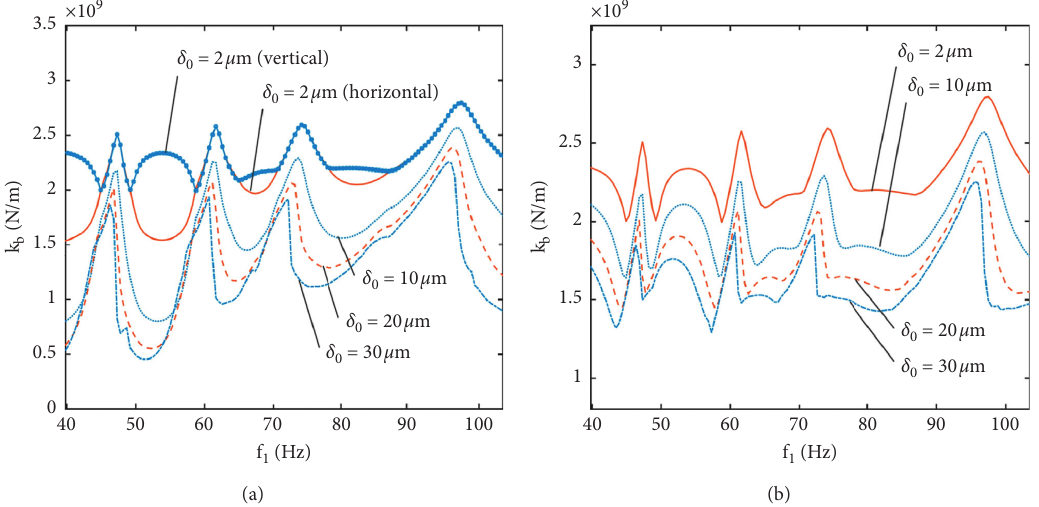
Figure 8: Equivalent stiffness of intershaft with different